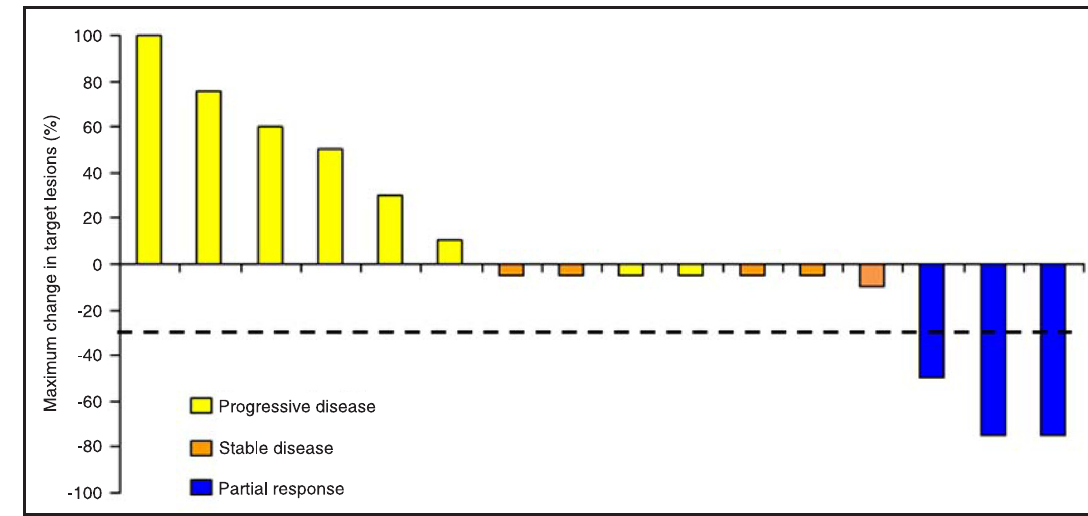
Figure 1. Best overall response regarding change in the target lesion measurement determined on the basis of the Response Evalu- ation Criteria in Solid Tumors (RECIST).